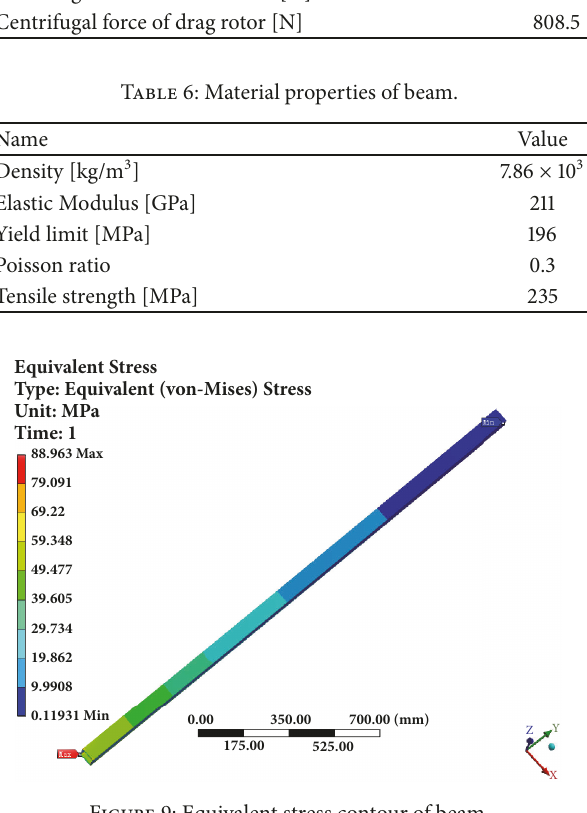
Figure 9: Equivalent stress contour of beam.